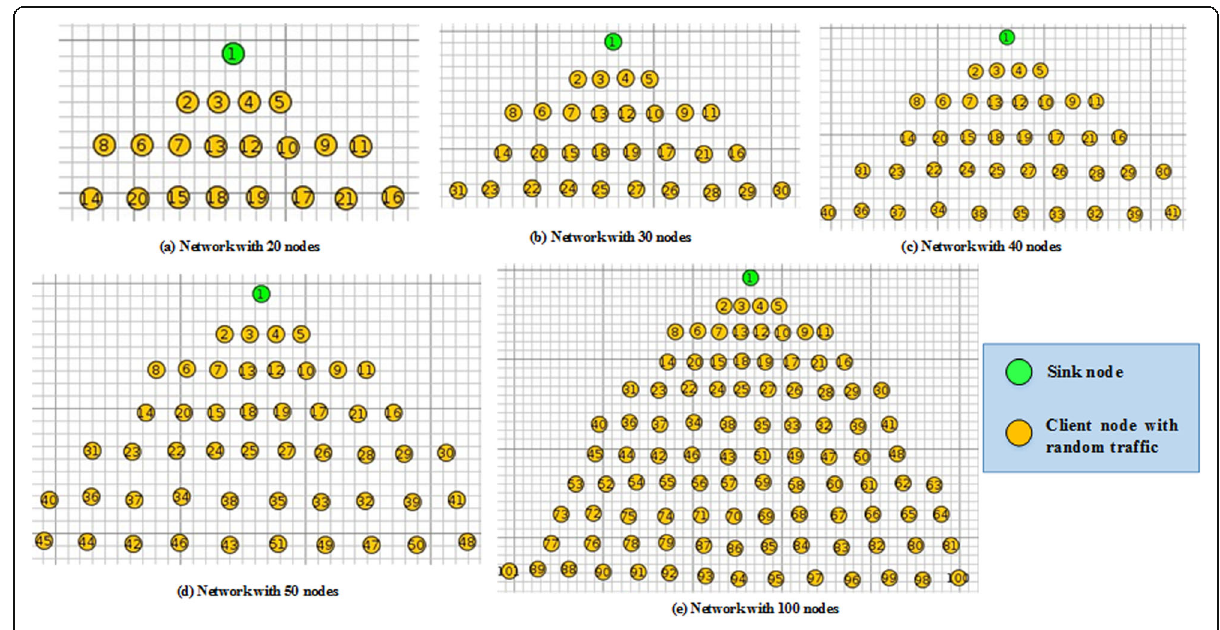
Fig. 6 Scenario II: RPL routing topology with random heterogeneous traffic load